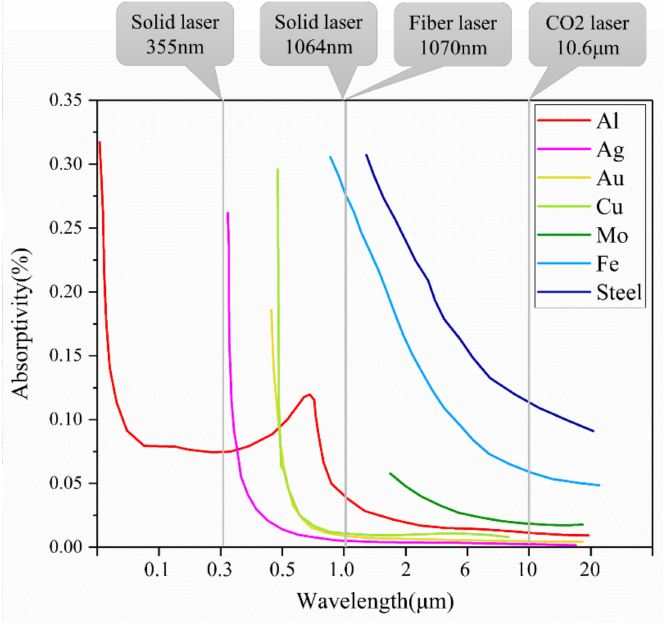
Figure 1. The absorption rate of common